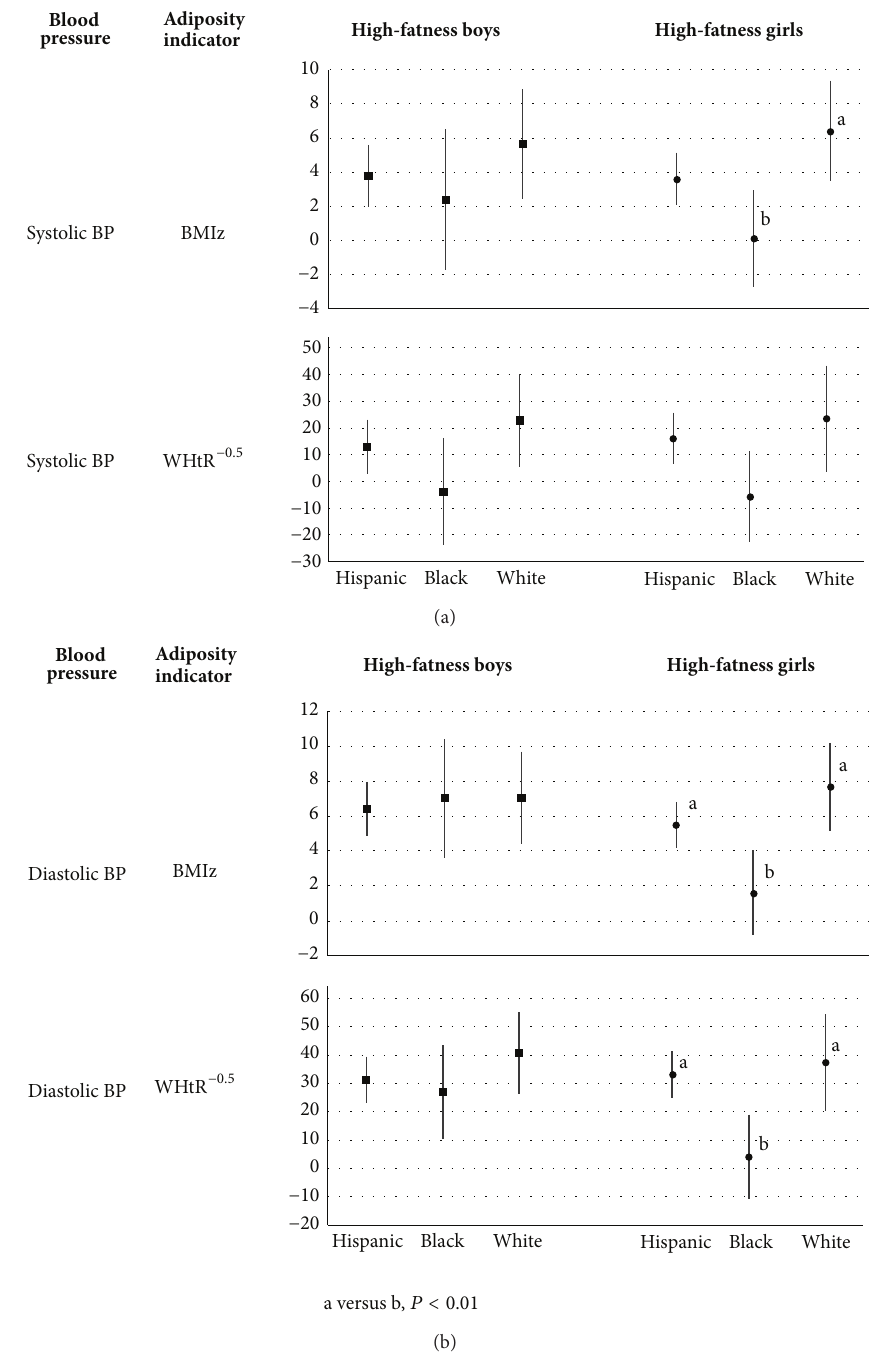
Figure 1: Within the high-fatness subpopulations, the point estimates (with 95% confidence intervals) represent here the slopes of the associations between blood pressure and either BMIz or WHtR for 3 predominant ancestral groups (Hispanic, black, and white). Black participants exhibited no linear associations between systolic blood pressure and increasing adiposity (a). Diastolic blood pressure was related to increasing adiposity for black boys, but not black girls